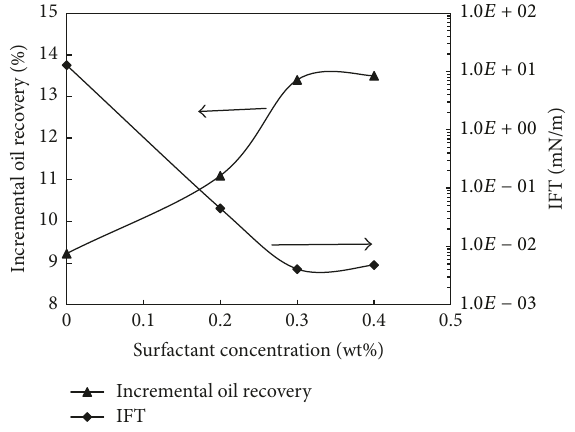
Figure 8: Relationship of IFT and incremental oil recovery when surfactant concentration varies. The polymer concentration is 1500 mg/L.